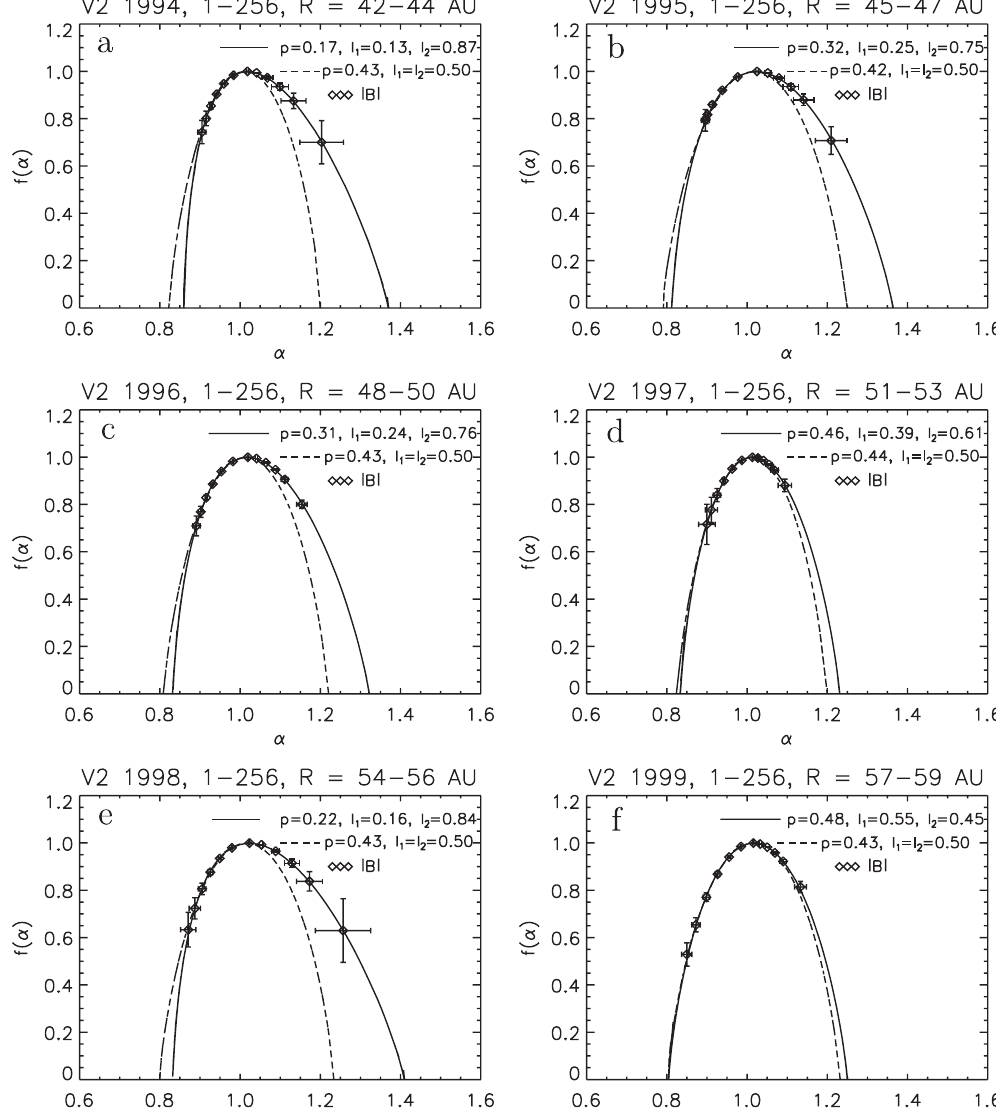
Fig. 4. The singularity spectrum f (α) as a function of a singularity strength α . The values are calculated for the weighted two-scale (continuous lines) model and the usual one-scale (dashed lines) p model with the parameters fitted using the magnetic fields (diamonds) measured by Voyager 2 in the distant heliosphere (beyond the planetary orbits) at (a) 42–44AU, (b) 45–47AU, (c) 48–50AU, (d) 51–53AU, (e) 54–56AU, and (f) 57–59AU,